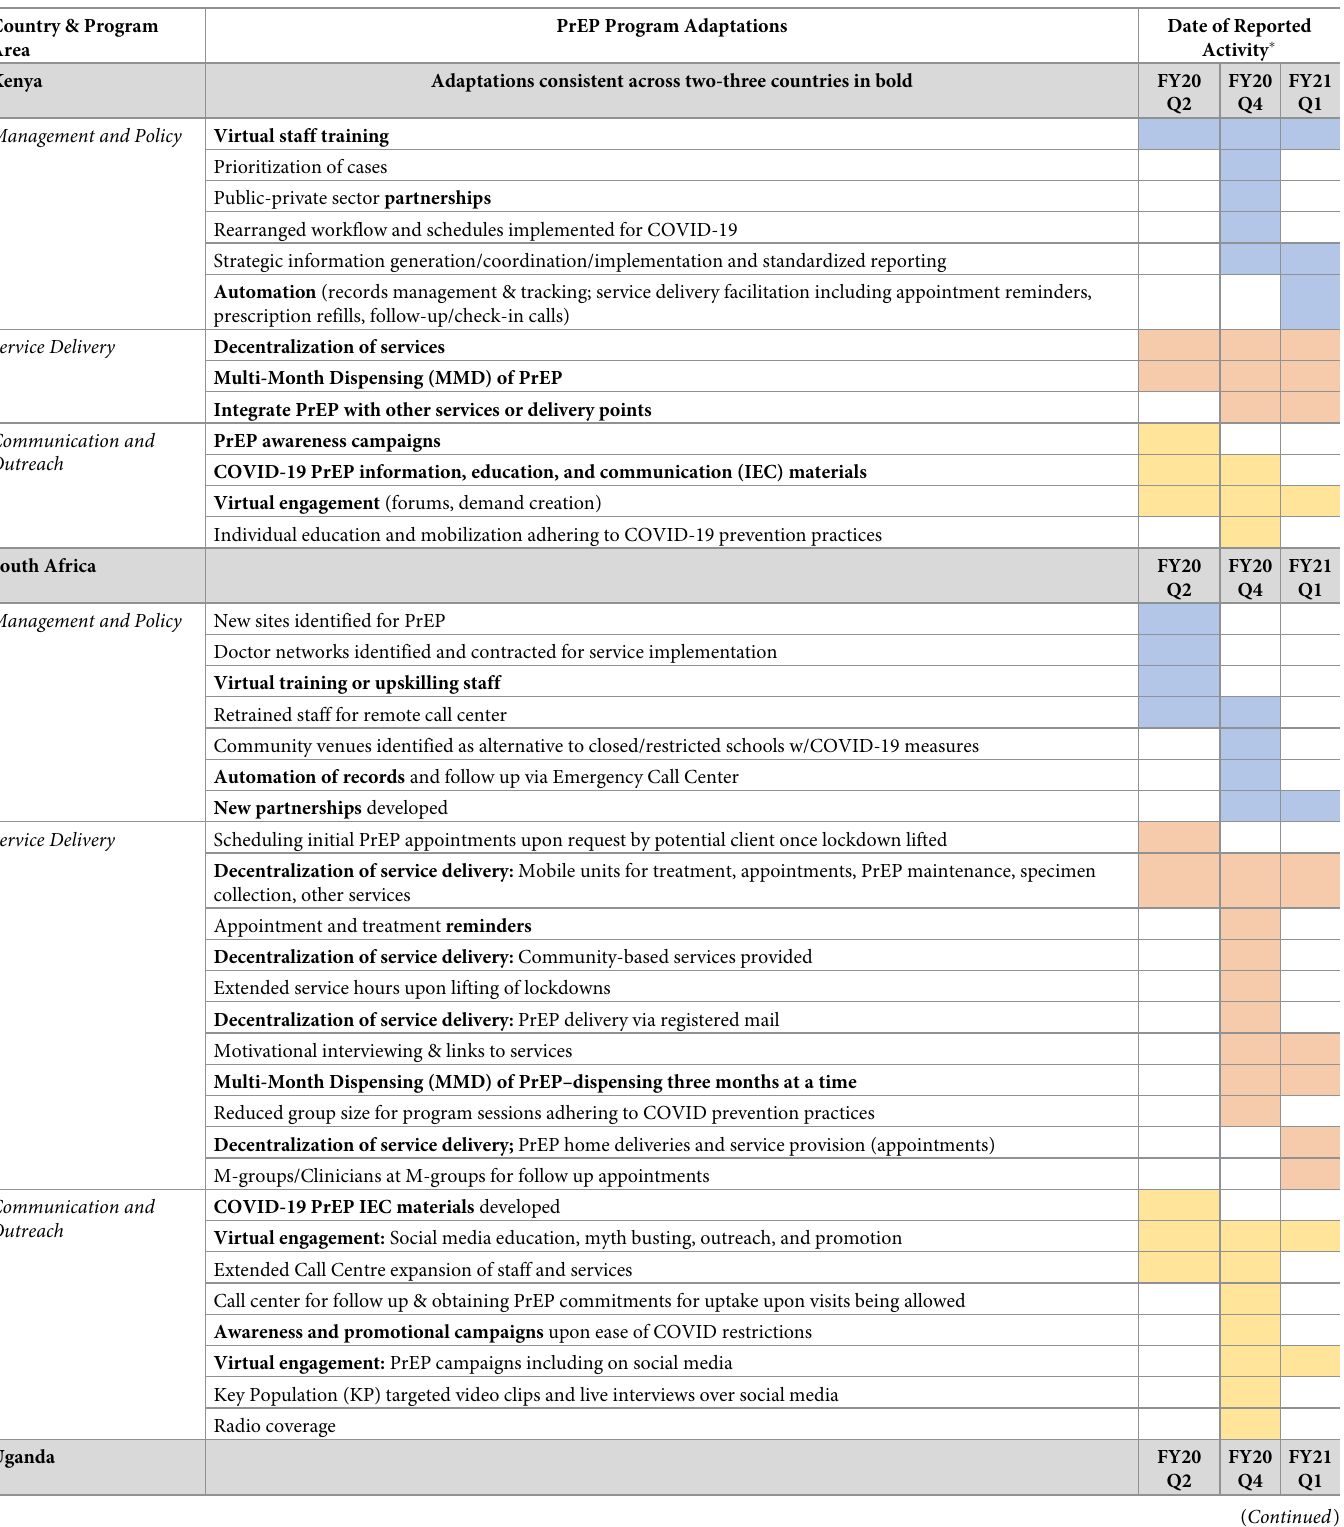
Table 4. Summary of pre-exposure prophylaxis program adaptations by country and by population. Country & Program